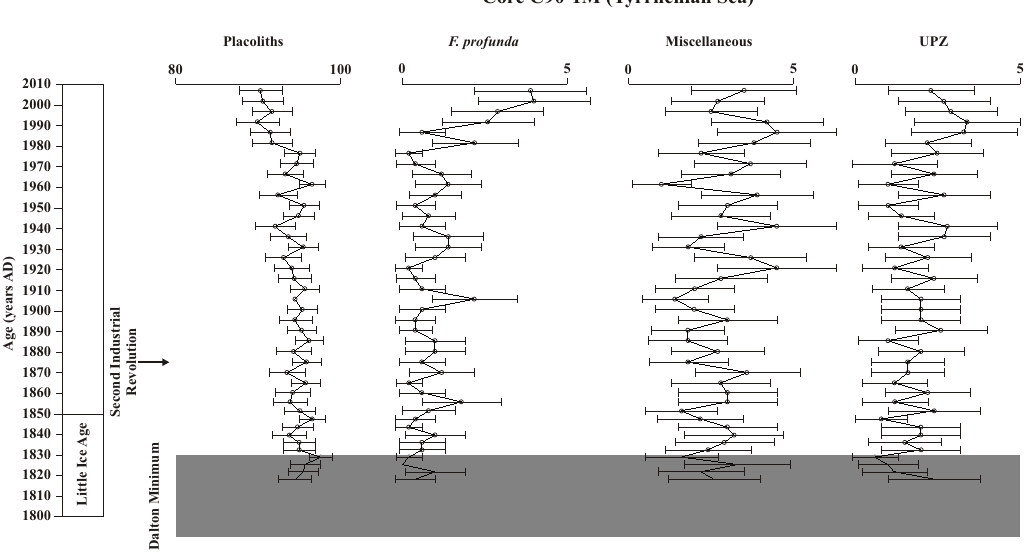
Fig. 4. Distribution patterns of calcareous nannofossil groups (percentage values) in core C90-1M (Tyrrhenian Sea), plotted versus age (years AD). The horizontal bars show the error associated to the countings, for a 95% of confidence level. The top of the Little Ice Age is indicated at 1850 AD, according to (Bradley, 2008; Verschuren and Charman, 2008; Wanner et al., 2008). The Dalton Minimum is also indicated by a gray